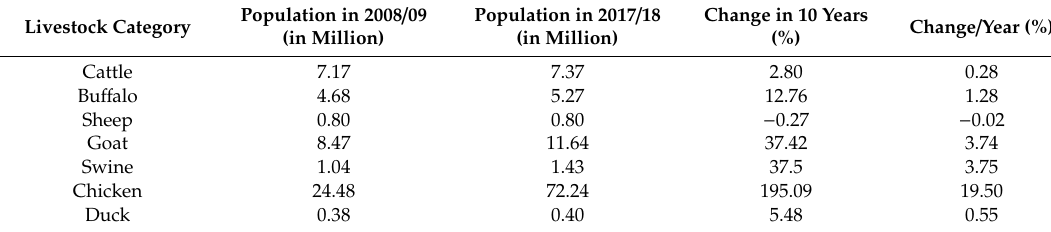
Table 1. Trend of livestock and poultry populations in Nepal in the last decade (2008 / 9–2017 / 18) [5].